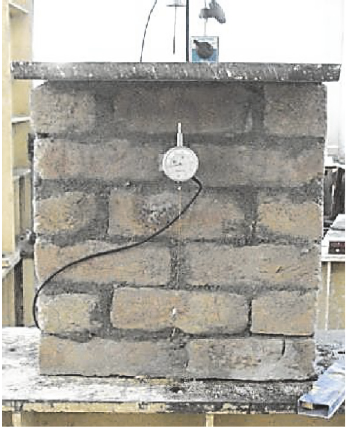
Figure 2: Compressive strength test of a masonry prism.